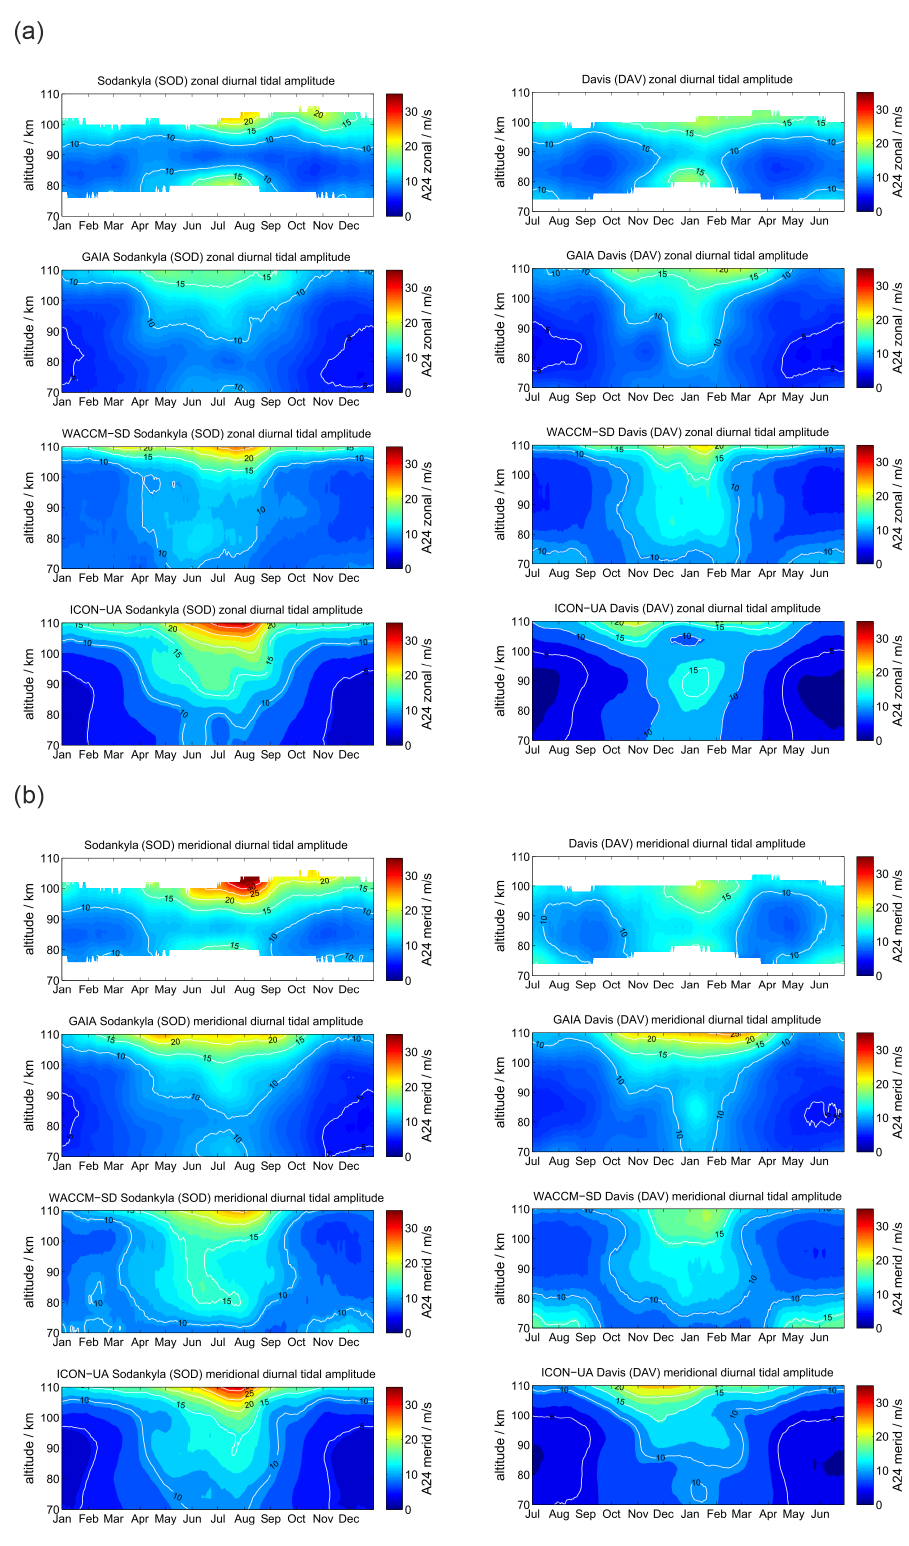
Figure 3. The same as Fig. 2, but for the diurnal tidal